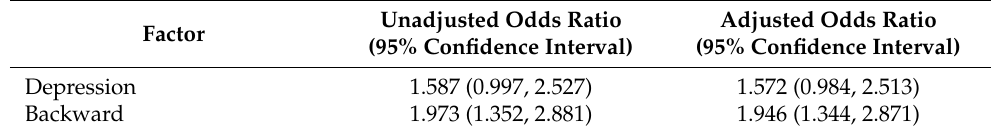
Table 3. Factors associated with poor sleep quality in nurses by stepwise method.